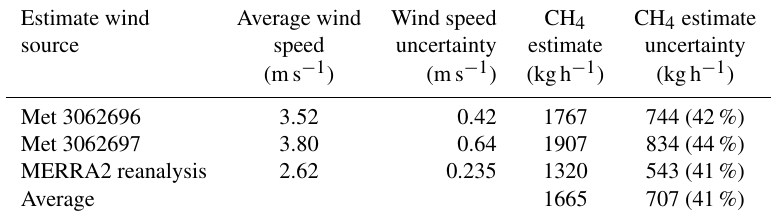
Table 4. AVIRIS-NG data captured on 14 August 2017, 3d prior to the F04 flight, is estimated using three sources of wind data.